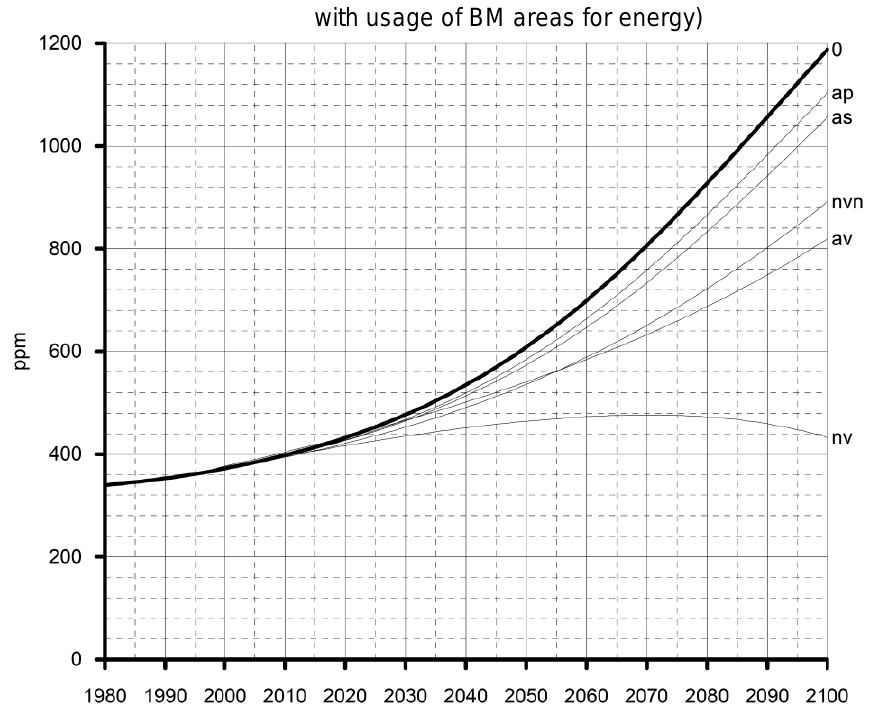
Figure 5. In a “+3%/a” CO 2 emission growth scenario, when dedicating 1% of areas for biomass production, all five described types of biomass scenarios ( with combustion of standing biomass on possibly deforested areas) show a high to extremely high effect on the atmospheric CO 2 concentration (from ~420 to 1200 ppm in 2100) — but the downside is that the globe would be fully deprived of either natural or agricultural vegetation and hence uninhabitable.